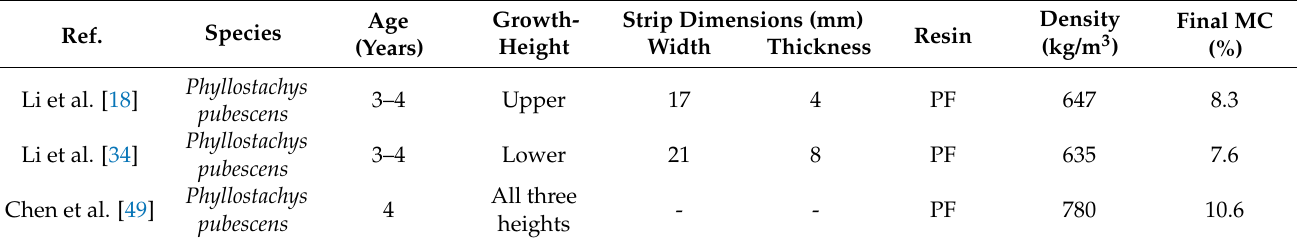
Table 2. Manufacturing parameters reported in the LBL